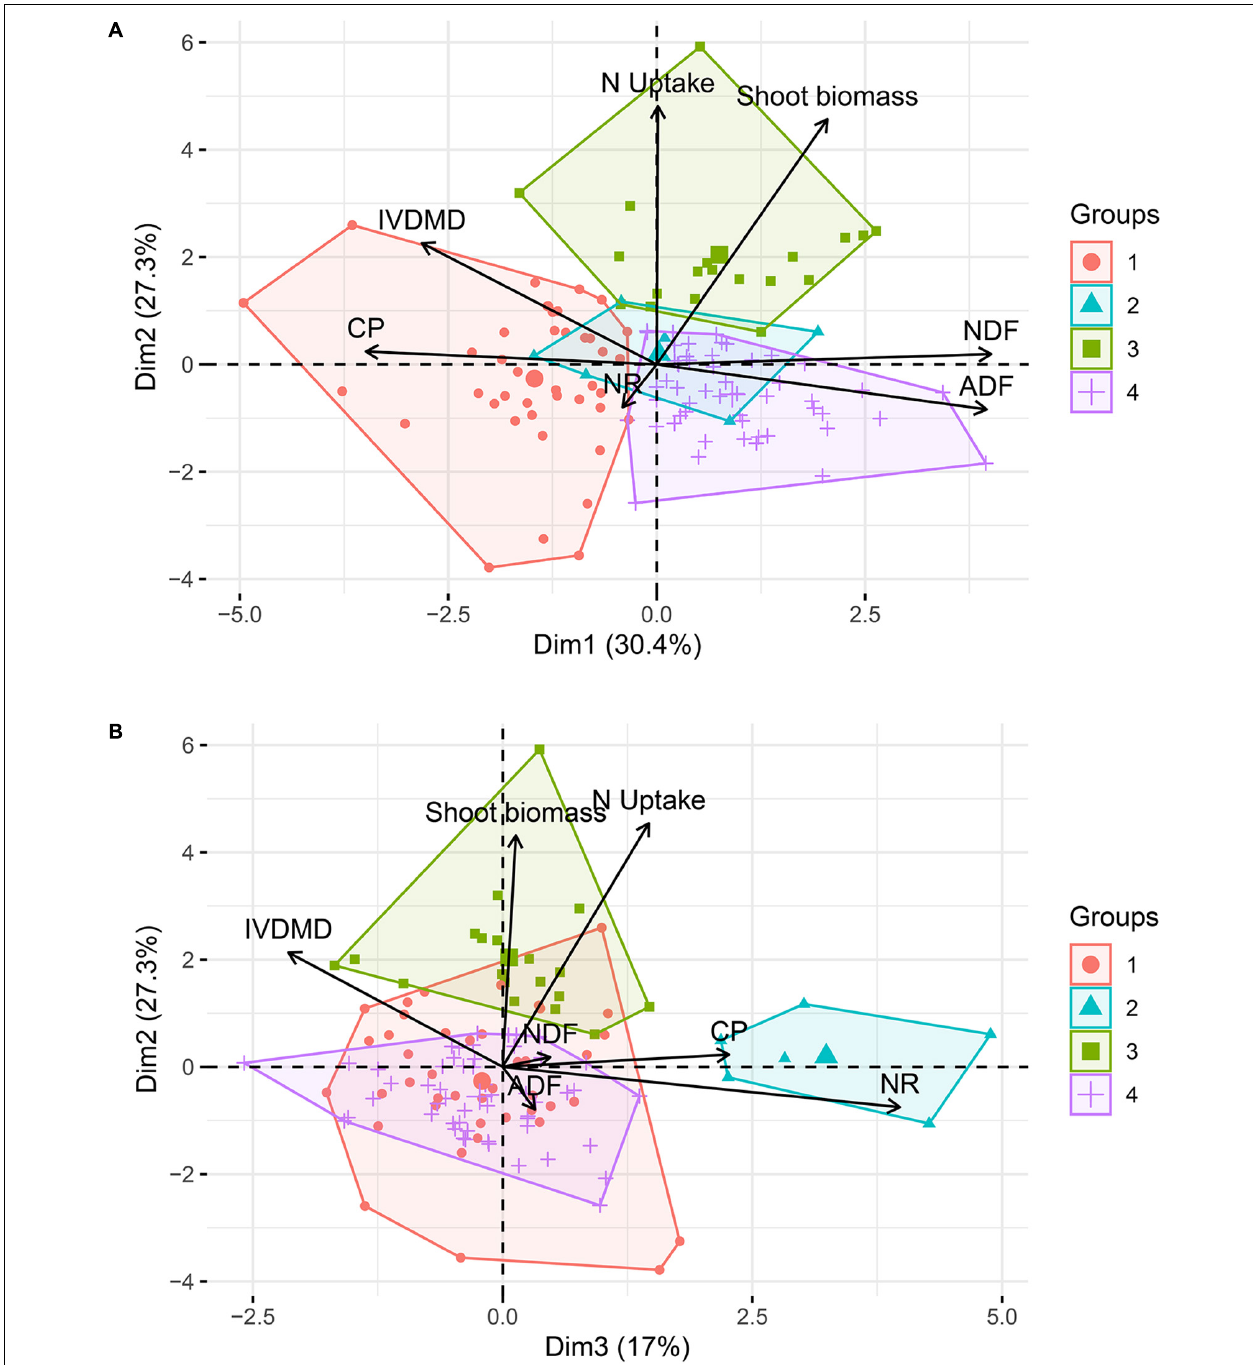
FIGURE 4 | Cluster analysis based on principal components of the germplasm collection of M. maximus . Cumulative variance accounts for 74.7%. (A) View of the first two dimensions. (B) View of dimensions 2 and 3. NR, nitrification rates; CP, crude protein; IVDMD, in vitro dry matter digestibility; ADF, acid detergent fiber; NDF, neutral detergent fiber. Dimension 1 (30.4% of variation) mainly integrated the nutrition quality parameters of NDF, ADF, IVDMD, and CP. Dimension 2 (27.3% of variation) represented N Uptake and Shoot biomass. Dimension 3 (17% of variation) largely represented